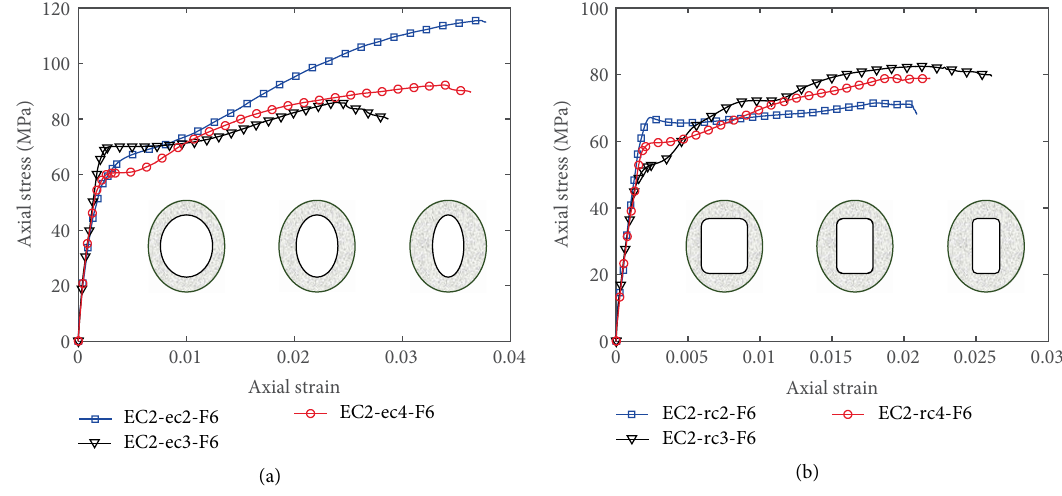
Figure 12: Effect of void area ratio. (a) EE-DSTCs. (b)